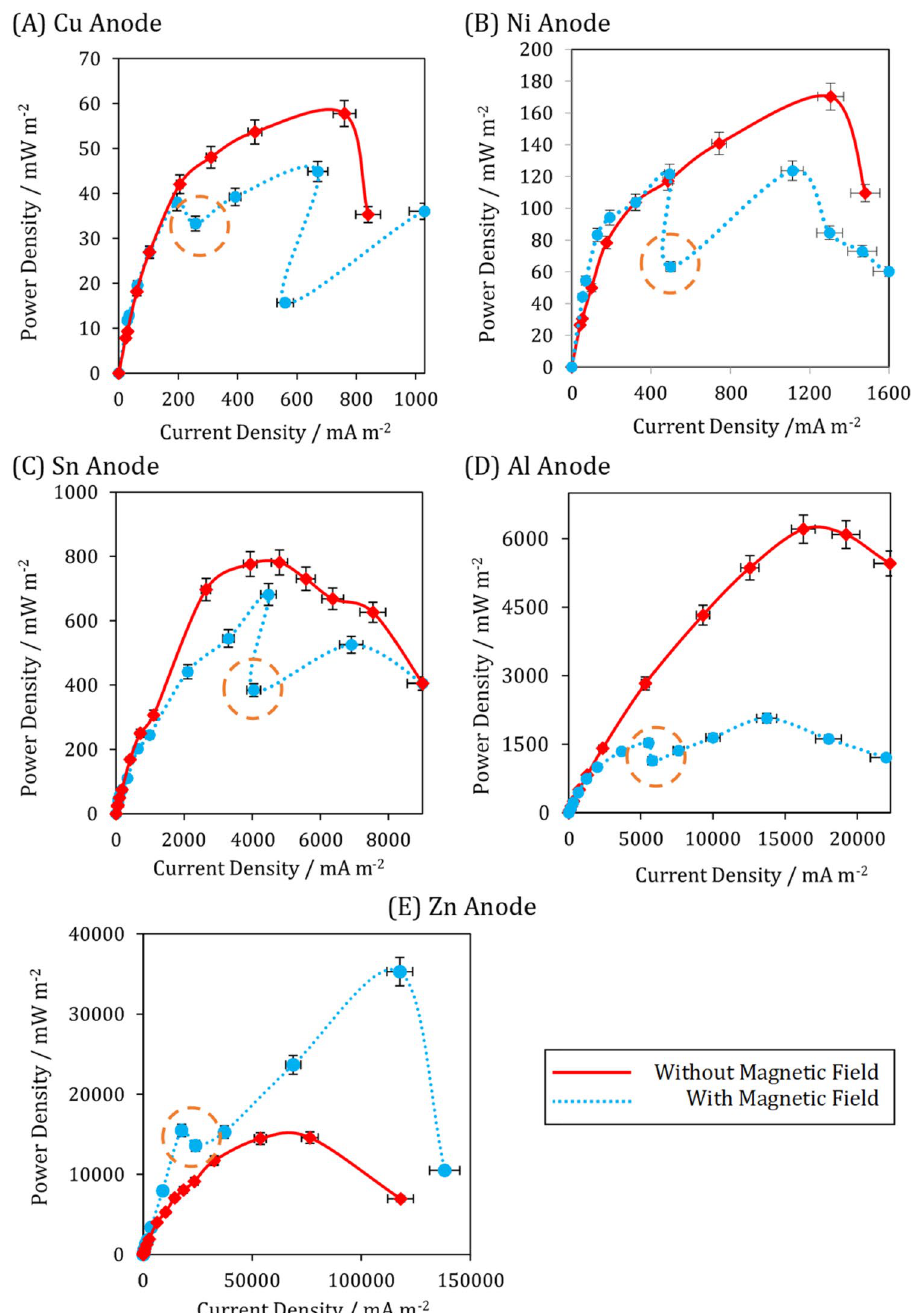
Figure 5. The effect of static magnetic field on the performance of the metal-based electrodes of the microfluidic MFCs engaged with Shewanella oneidensis MR-1 in the optimized substrate flow rates (Table S1 in Supplementary file). The error bars represent the variation of power and current densities among repeated